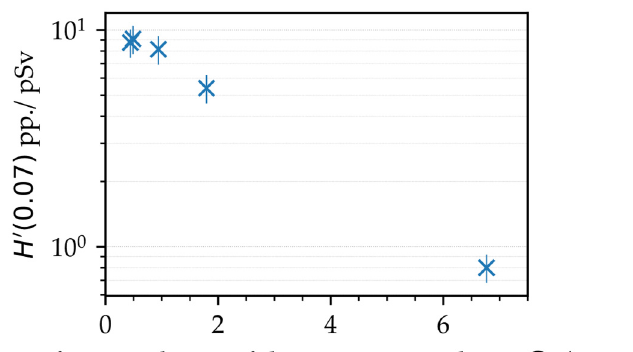
Figure 3. X-ray emission dose per pulse as a function of the area roughness of specifically laser pre-textured AISI 304 substrate surfaces.